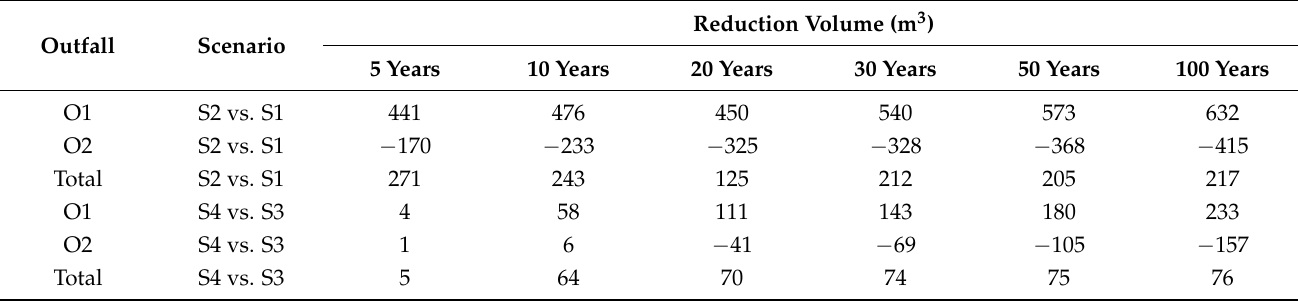
Table 8. Reduction volume of total outfall flow for the discharge route scenarios (S2 and S4) compared to traditional roof scenario (S1) and green roof scenario (S3).